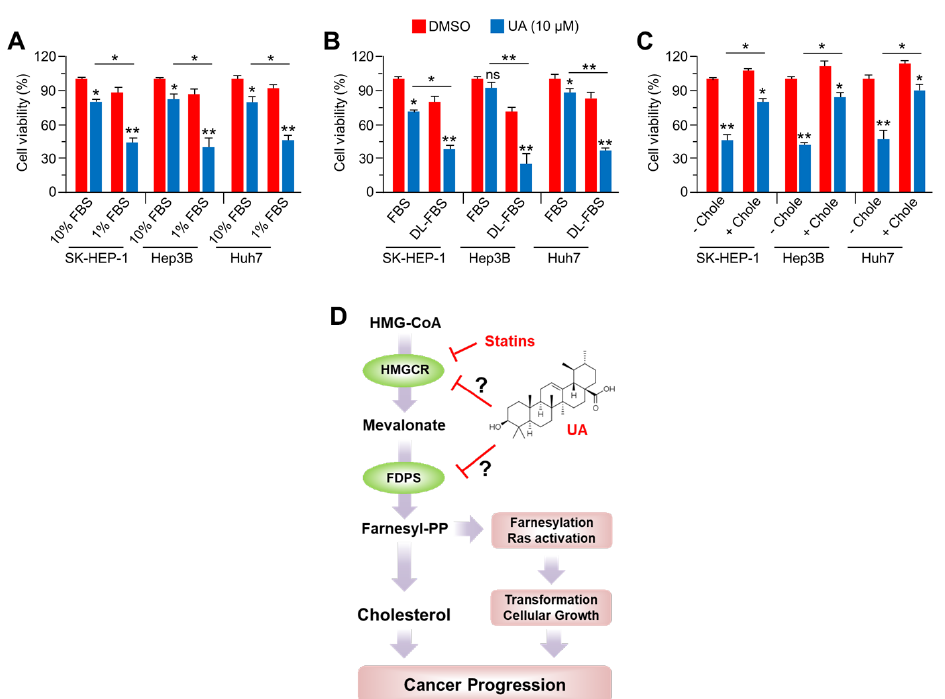
Figure 6. Cholesterol is required for the anti-cancer e ff ect of UA. ( A ) Three cell lines (SK-HEP-1, Hep3B, and Huh7) were incubated with DMSO or UA (20 µ M) for 24 h with 10% FBS or 1% FBS. Cell viability was measured by crystal violet staining, and the values represent the mean ± SD from three independent experiments performed in triplicate; * p < 0.05 and ** p < 0.01. ( B ) Cells were incubated with DMSO or UA (20 µ M) for 24 h with 10% normal FBS or lipoprotein-depleted FBS (DL-FBS). The values represented the mean ± SD from three independent experiments performed in triplicate; * p < 0.05 and ** p < 0.01. ( C ) Cells were incubated with or without 0.5 mM water-soluble cholesterol for 2 h prior to UA (20 µ M) treatment, followed by further incubation with DMSO or UA (20 µ M) for 24 h with 1% FBS. The values represent the mean ± SD from two independent experiments performed in triplicate; * p < 0.05 and ** p < 0.01. ( D ) Speculated molecular mechanism of anti-cancer e ff ects of UA.